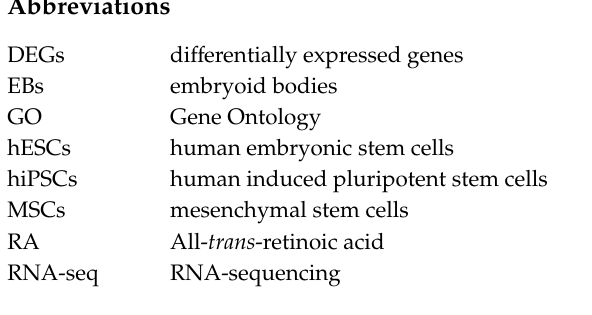
Figure S1: E ff ect of short-term treatment with high RA concentration on the e ffi ciency of di ff erentiation of human iPSCs into EBs and MSCs; Figure S2: The e ff ect of high concentrations of RA on EB formation; Figure S3: Absence of hematopoietic markers’ expression in the PSC-derived MSCs; Figure S4: Di ff erentiation of hPSC-derived MSCs into chondrocytes and osteocytes; Figure S5: hiPSC-derived MSCs display an enhanced di ff erentiation potential into adipocytic lineage; Figure S6: Transcriptomic comparison of EBs treated with RA versus untreated EBs; Table S1: The details of the antibodies used for flow cytometry and immunostaining; Table S2: The list of primers for qPCR used in this study; Table S3: Top upregulated and downregulated genes at days 3 and 5 in cells treated with 0.1 µ M and 10 µ M RA compared with those treated with 0 µ M ( p < 0.05); Table S4: Enriched functions in the upregulated di ff erentially expressed genes (DEGs) in day 5-old EBs treated with 10 µ M RA compared with those untreated ( p < 0.05); Table S5: Enriched functions in the downregulated di ff erentially expressed genes (DEGs) in day 5-old EBs treated with 10 µ M RA compared with those untreated ( p < 0.05); Table S6: RNA sequencing data for MSCs obtained from H9 hESCs without or with 10 µ M RA treatment. Genes encoding factors that mediate the immunoregulatory and paracrine functions of MSCs are in black. Genes encoding receptors for pro-inflammatory factors that are involved in MSC activation are in